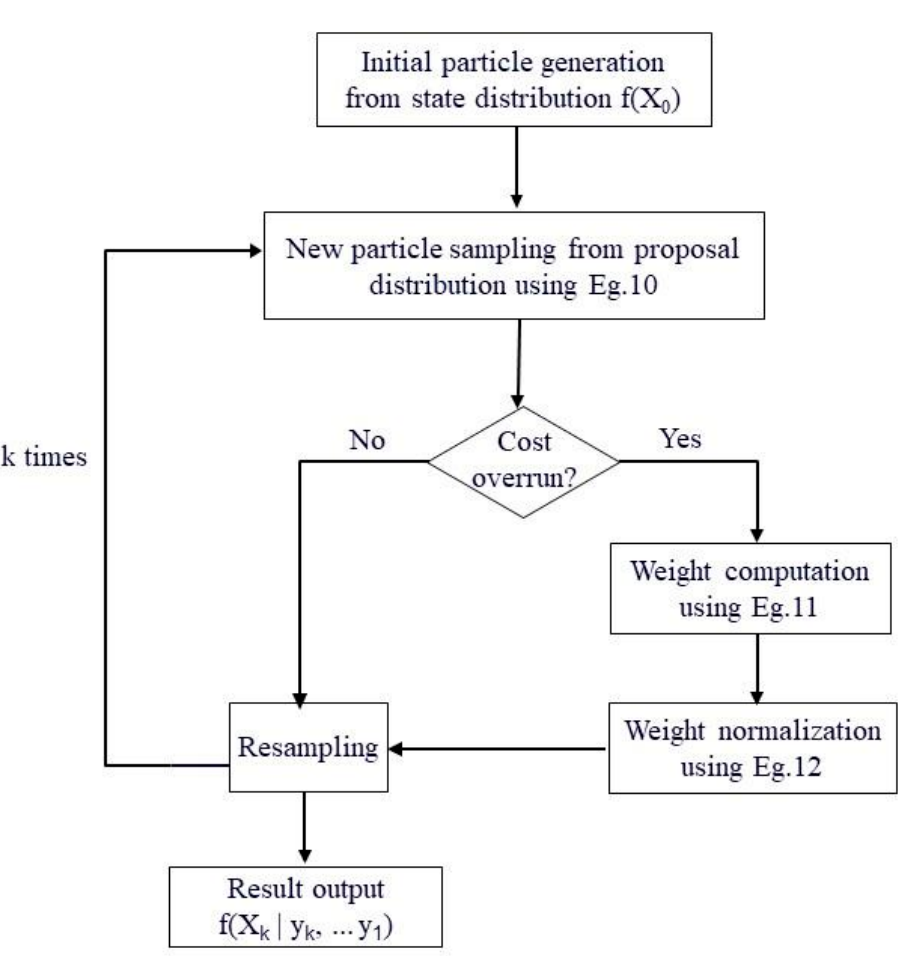
Figure 2. Overall data sampling process of the real-time Bayesian updating model.